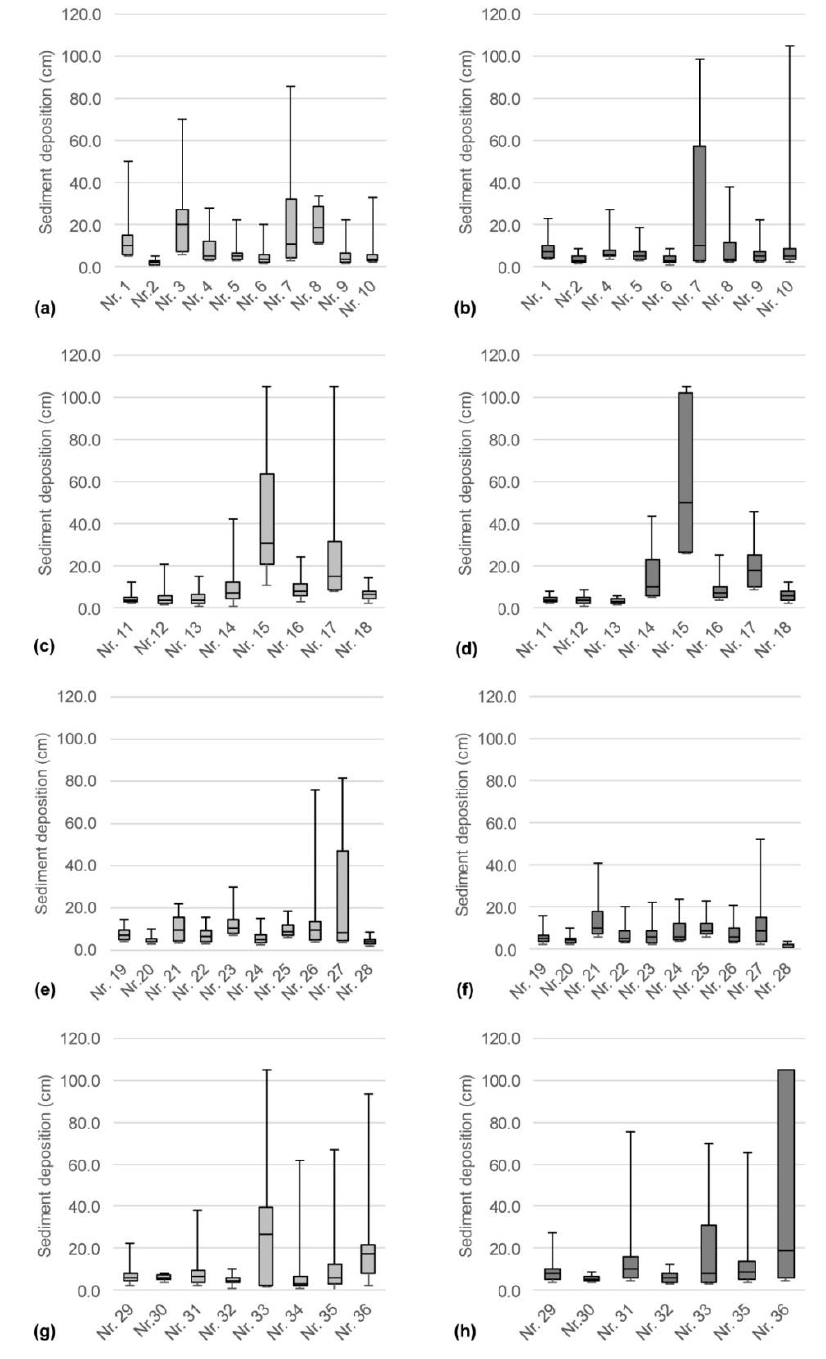
Figure 4. Comparison of sediment deposits at selected gravel bars (n = 36) during the pre- ( a,c,e,g ) and post-monitoring ( b,d,f,h ) of the project.